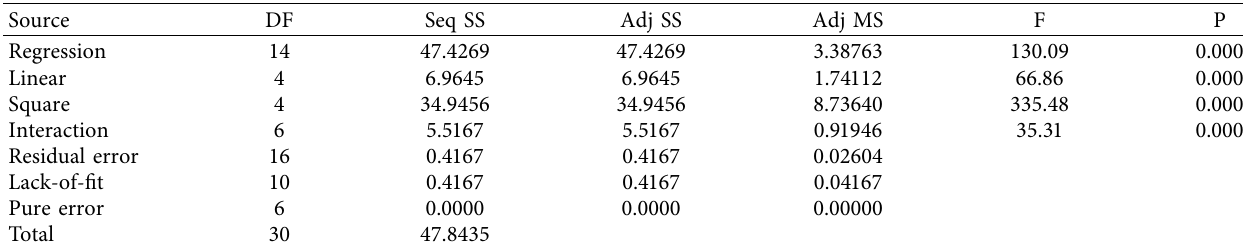
Table 6: Analysis of variance for Ra ( µ m).